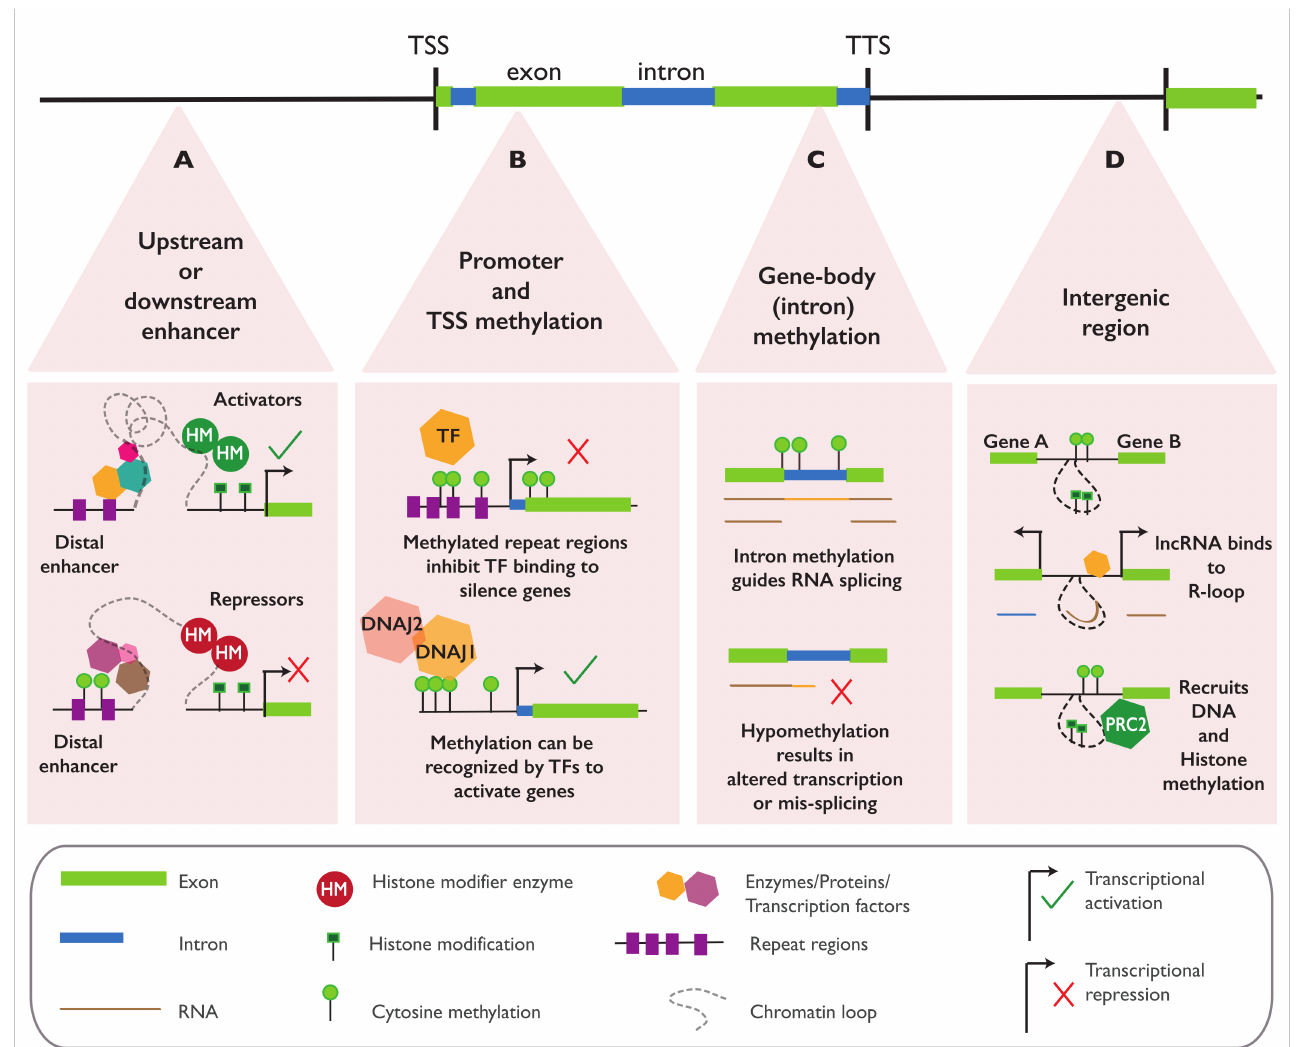
Figure 5. Different mechanisms for gene regulation by epialleles. In the vicinity of a gene, methylation can occur in several regions, with a distinct function in each. In regions upstream or downstream of the genes that house enhancer sequences, the presence of DNA methylation can promote the formation of a single-loop structure to recruit repressive histone marks, causing the downregulation of the associated gene. The removal of methylation in the distal enhancer can promote transcription factor (TF) binding, the recruitment of permissive histone marks, and the formation of a multiloop structure, which, together, promote the expression of the associated gene ( A ). At the promoter and transcription start-site (TSS) of a gene, DNA methylation (often at repeat-rich regions) can inhibit TF binding and recruit repressive histone marks that, in turn, repress or completely silence the transcription of the associated gene. Depending on the sequence and methylation context, DNA methylation can also have a positive effect on the gene expression; it can recruit protein complexes (such as DNAJ1 and DNAJ2) that promote the expression of the genes proximal to methylated sites ( B ). In the gene body, DNA methylation may be involved in the regulation of intron-splicing in mRNA. The loss of methylation in the intron can lead to the mis-splicing and premature transcript termination of the associated gene ( C ). DNA methylation can also modulate chromatin interactions between two adjacent genes, together with a repressive histone mark promoting the formation of a loop structure encompassing the two adjacent genes and repressing both genes. Upon the removal of methylation in the region, the chromatin loop is opened, and permissive histone marks replace the existing marks, resulting in the activation of both genes. In a self-feedback mechanism, the excessive accumulation of gene transcripts leads to the generation of lncRNA, reformation of the chromatin loop, hypermethylation, and the deposition of repressive histone marks (by proteins such as PRC2) in this region ( D